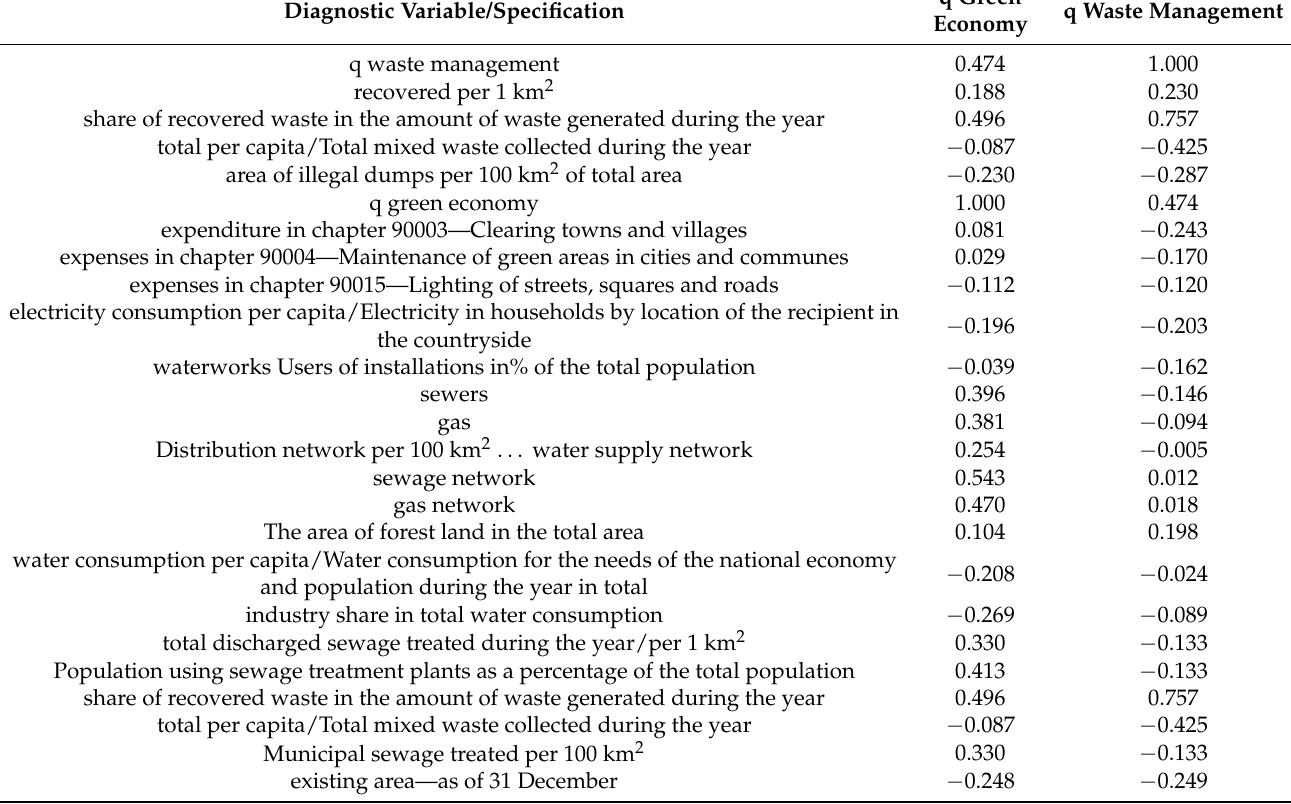
Table 7. Coefficients of correlation between the value of the synthetic measure, waste management, green economy and diagnostic variables of their structure for districts in 2020 and 2020.